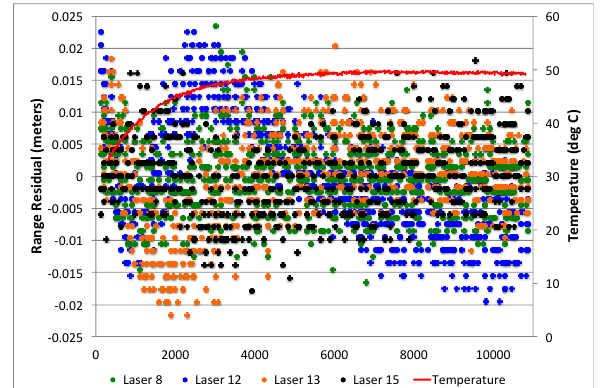
Figure 6: Sample Long-Term Range Residuals for